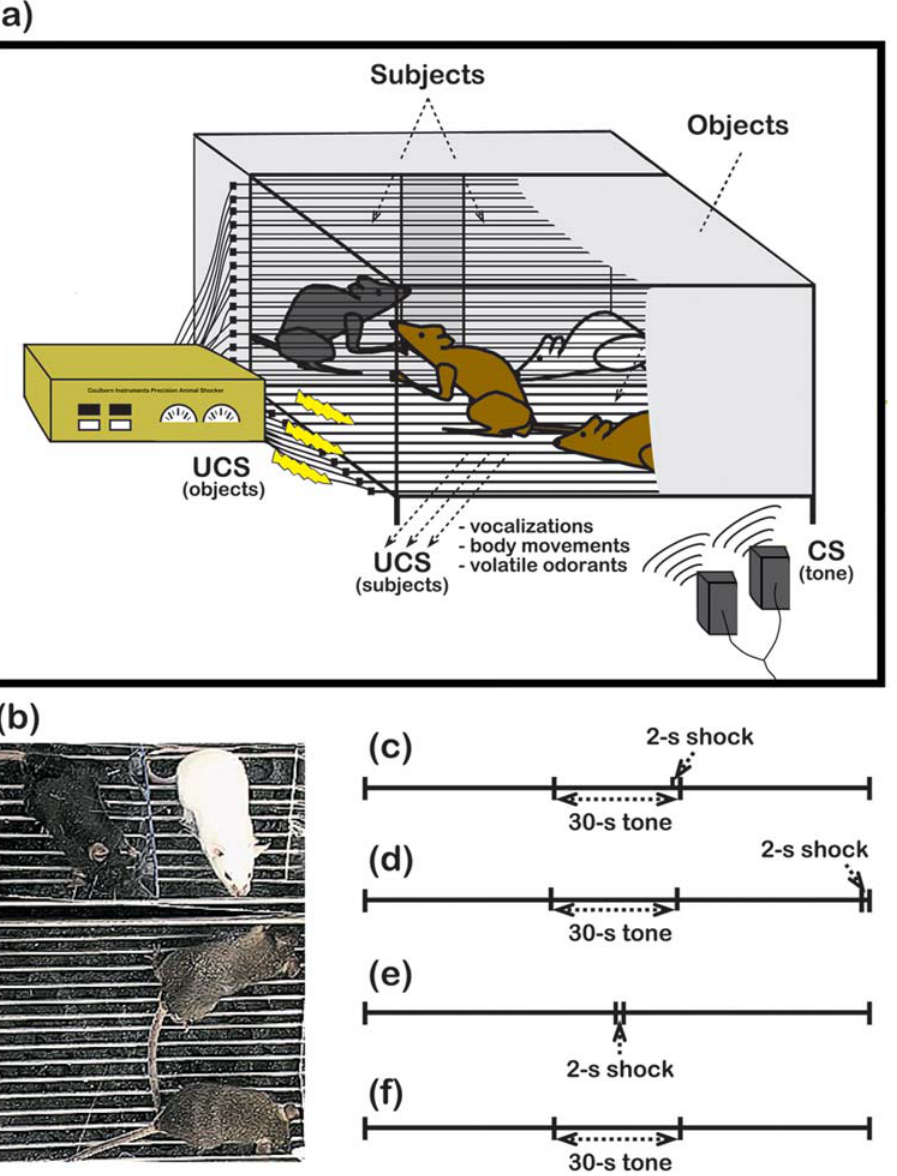
Figure 1. The fear conditioning apparatus and conditioning schedules. (a) Subject mice from the BALB ( white mouse ) and B6 ( dark grey mouse ) strains were separated from 2 novel, F1 object mice ( brown mice ) that received a 2-s electrical shock (UCS objects ) and/or a 30-s tone (CS) under different conditioning schedules (pre-exposure sessions). Both subjects and objects were exposed to the CS, but only objects directly experienced the UCS. Subjects had access to object distress cues (UCS subjects ) that were emitted as a consequence of receiving the UCS. (b) Photograph of the fear conditioning apparatus from an overhead perspective. (c–f) Each conditioning schedule is representative of one 120-s trial.